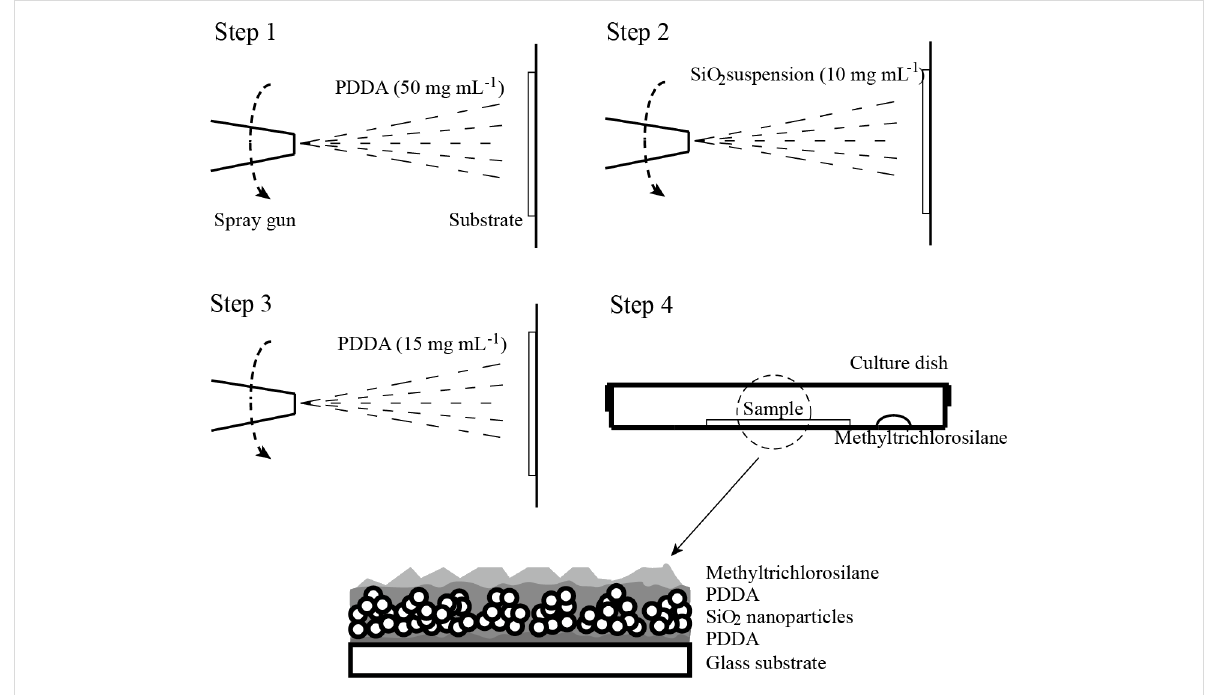
Figure 1: Schematic illustration of the preparation procedures for the superoleophilic samples. The dashed arrow is the moving direction of the spray gun, which is parallel to the samples.